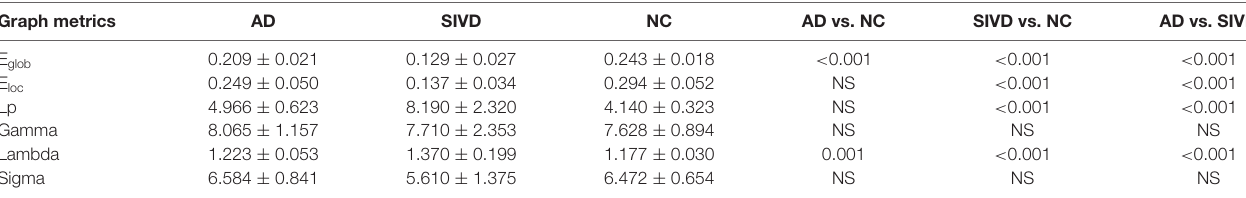
TABLE 2 | The group difference of topological parameters by network analysis. Graph metrics AD SIVD AD vs. NC SIVD vs. NC AD vs. SIVD